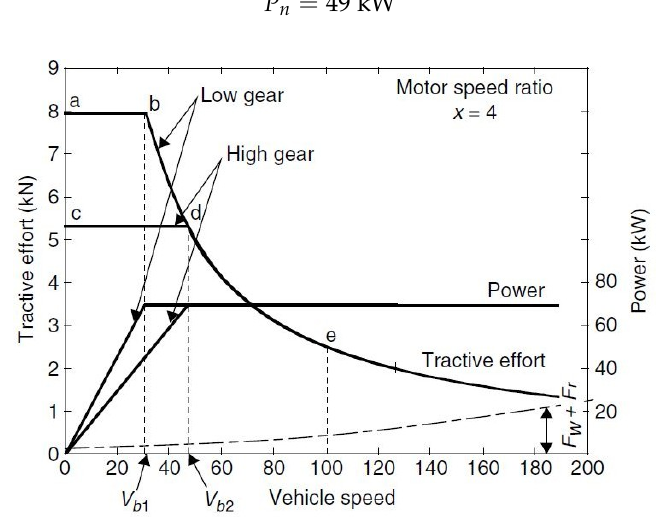
Figure 2. Torque/power-speed characteristic of a commercial electric motor. Figure 2. Torque / power-speed characteristic of a commercial electric motor.